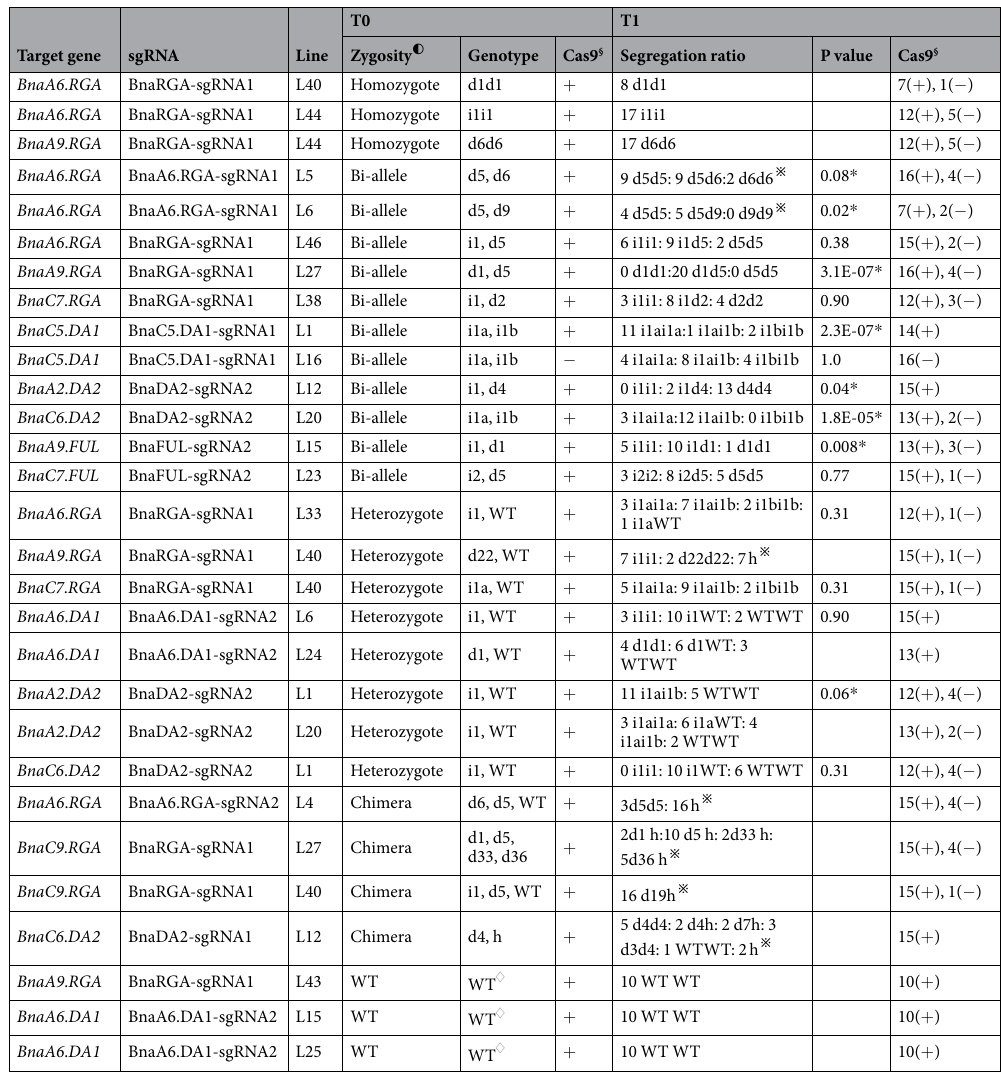
Table 4. Segregation patterns of CRISPR/Cas9-induced mutations in the T1generation. ◐ The zygosity of the homozygote, bi-allele, and heterozygote in T0 plants. ♢ WT, no mutations were identified. § Presence of Cas9 sequence: + , Cas9 positive; − , Cas9 negative; n.d., Not determined. ※ More data are needed to fully explain the T1 genotypes. d#, # of bp deleted from a target site; d#a, same number of deletion at one site; d#b, same number of deletion at other sites; i#, # of bp inserted at target site; i#a, same number of insertion at one site; i#b, same number of insertion of different nucleotide at the same site; c#, combined mutation; h, heterogeneous, more than one sequence detected in the sample. χ 2 test * P value <